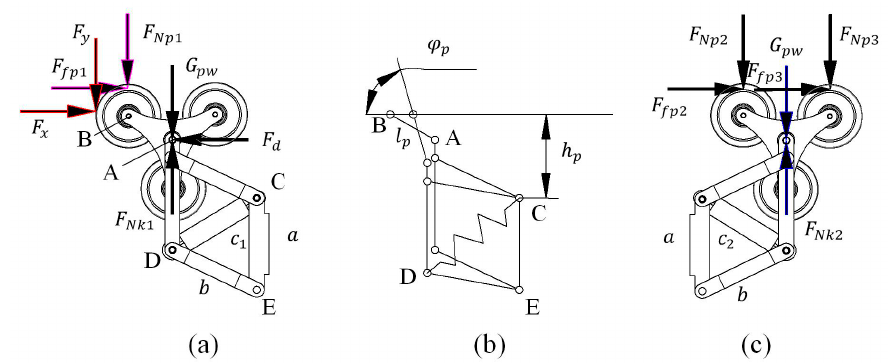
Figure 8. Force and deformation analysis of composite wheels: ( a ) Force analysis of the front composite wheel; ( b ) Suspension deformation of the composite wheel; ( c ) Force analysis of the rear composite wheel.